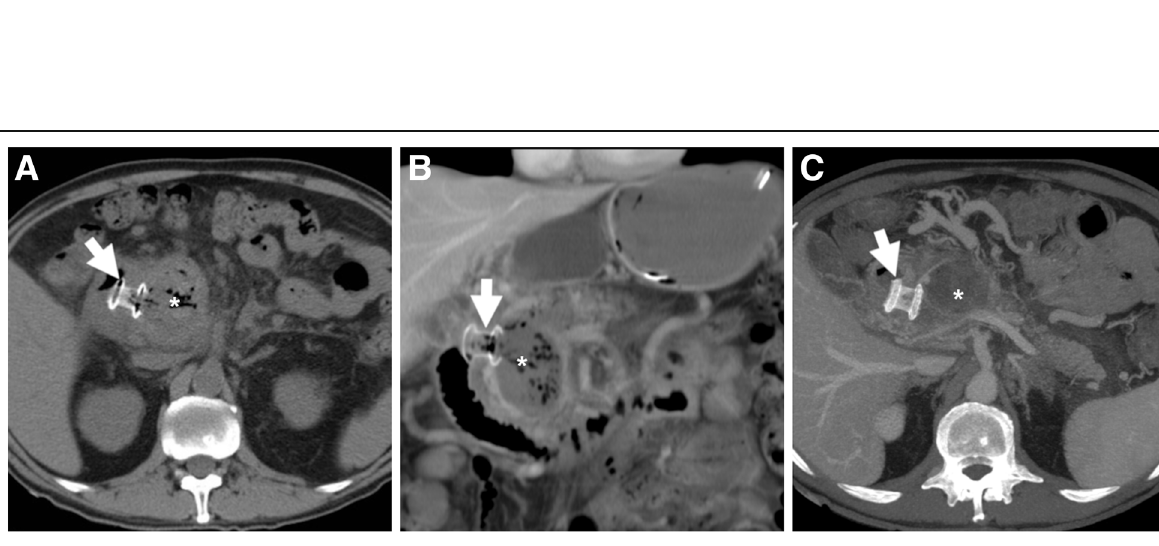
Fig. 8 Unenhanced ( a ) and post-contrast ( b , c ) MDCT images in a 78-year-old male showed placement of a saddle-shaped lumen-apposing metal stent (thick arrows) at the site of ECS at proximal duodenum, best visualised using MIP reconstruction ( c